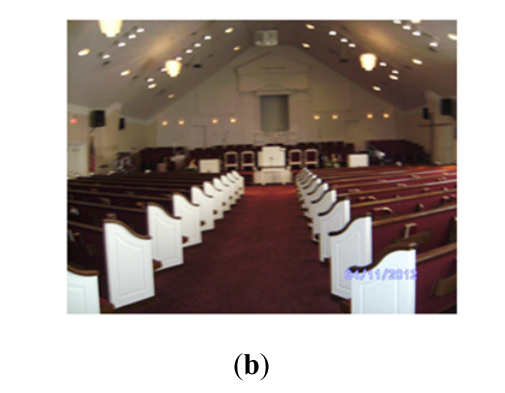
Figure 1. ( a ) The Clear Creek M.B.C. Building, November 2012 (previous building to the left, portion of newer building on the right; ( b ) The Clear Creek M.B.C. Sanctuary, November 2012.